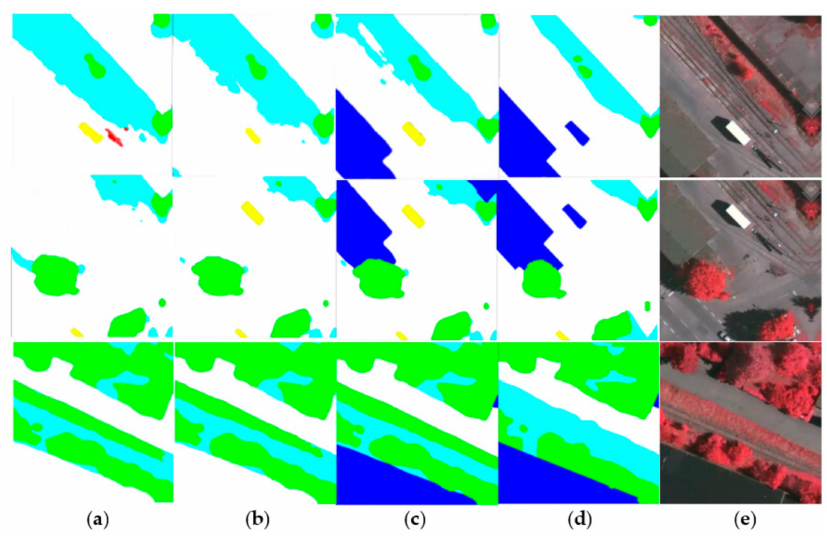
Figure 10. Visualization result of MFNet’s ablation study in the local area in the Vaihingen dataset: ( a ) Source FCN; ( b ) MFNet; ( c ) MFNet (CFM); ( d ) ground truth; and ( e ) the source image.